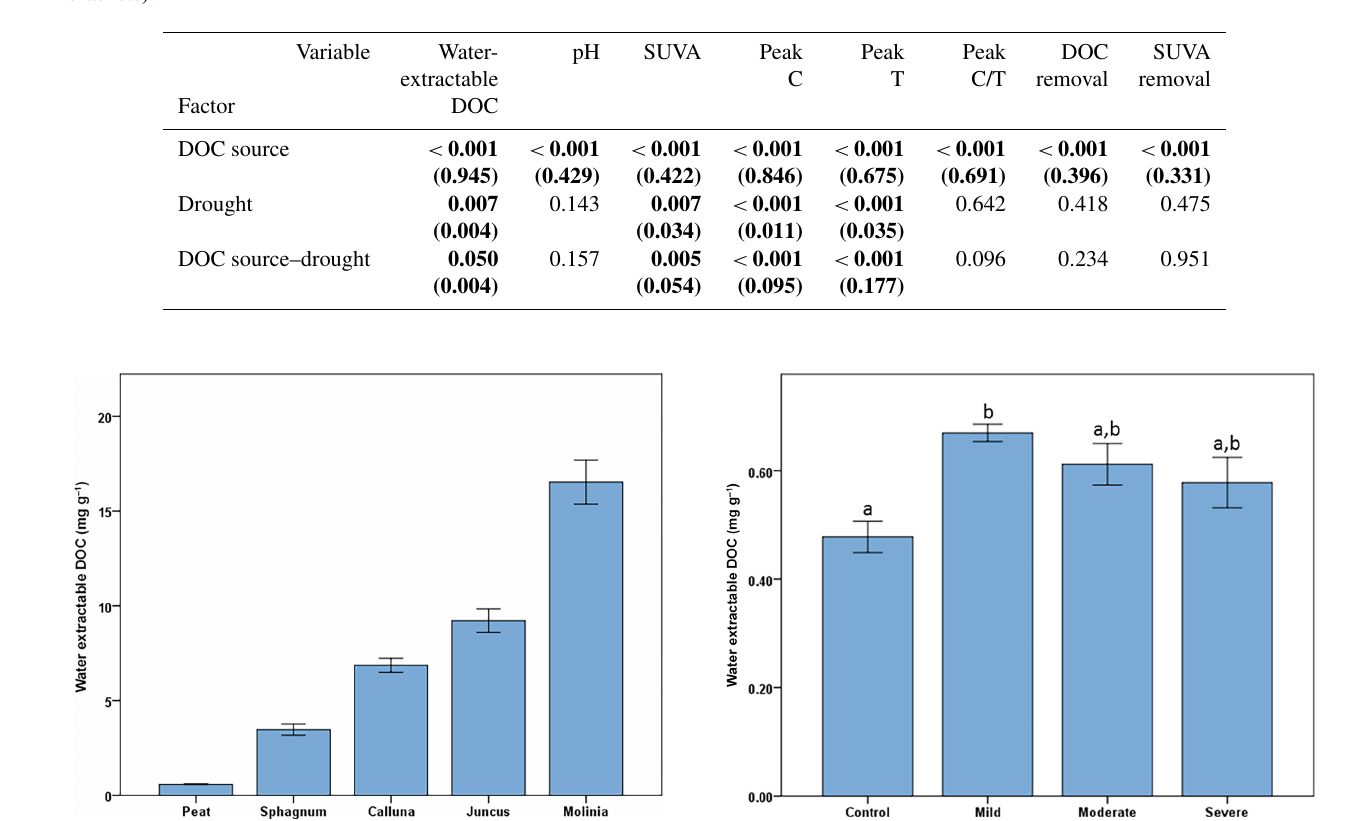
Table 1. p values from factorial ANOVA (significant values have been highlighted in bold and displayed with ω 2 estimate of effect size in brackets).